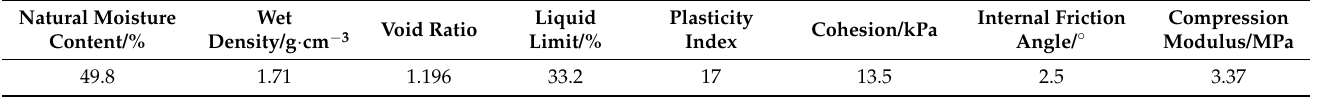
Table 1. Physical and mechanical properties of